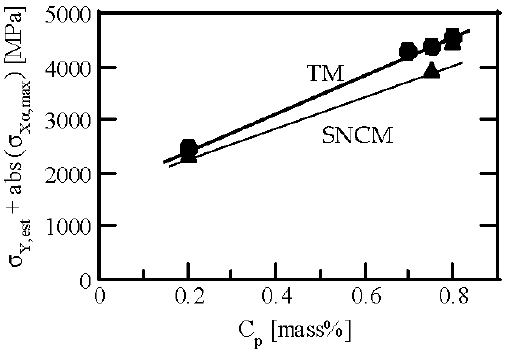
Figure 8. Relationship between the sum of the estimated yield stress and the absolute value of maximum compressive residual stress { σ Y,est + abs( σ X α ,max )} and carbon potential in vacuum ‐ carburization ( C P ) in TM ( ● ) and SNCM420 ( ▲ ) steels subjected to fine ‐ particle